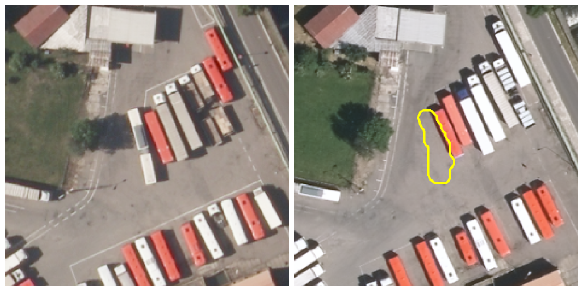
Figure 13. Left: aerial image (2010) Right: aerial image (2012) with a false indication of a demolished building